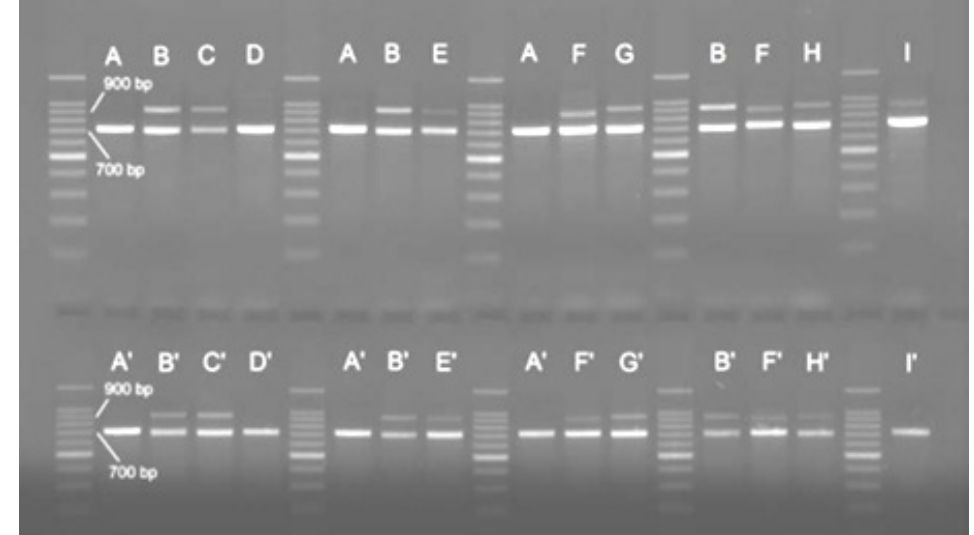
Figure 5. Band patterns given by amplifying the RP1 locus with universal primers. A, A’— H. huso ;